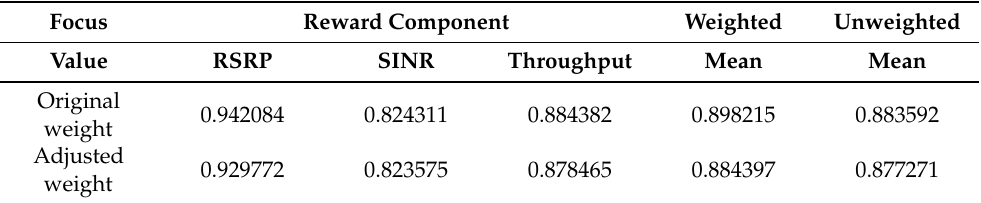
Table 4. Focus values of the agent with original and adjusted reward weight, which quantifies how much the desired properties are